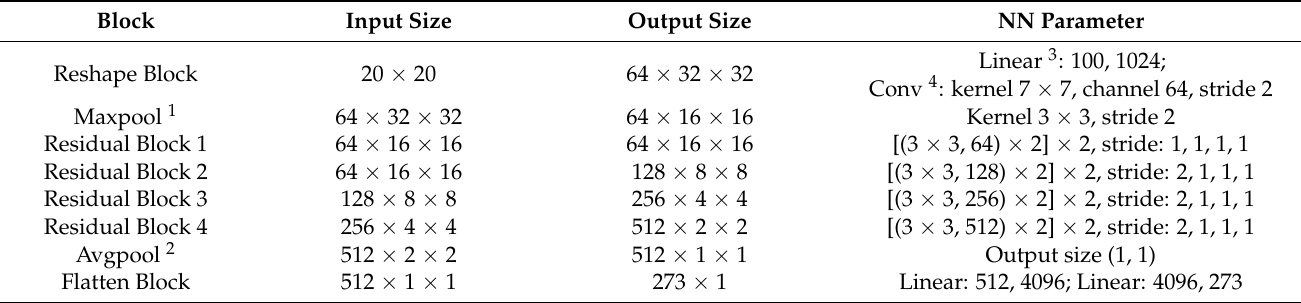
Table 1. The detailed architecture of the sim-NN.